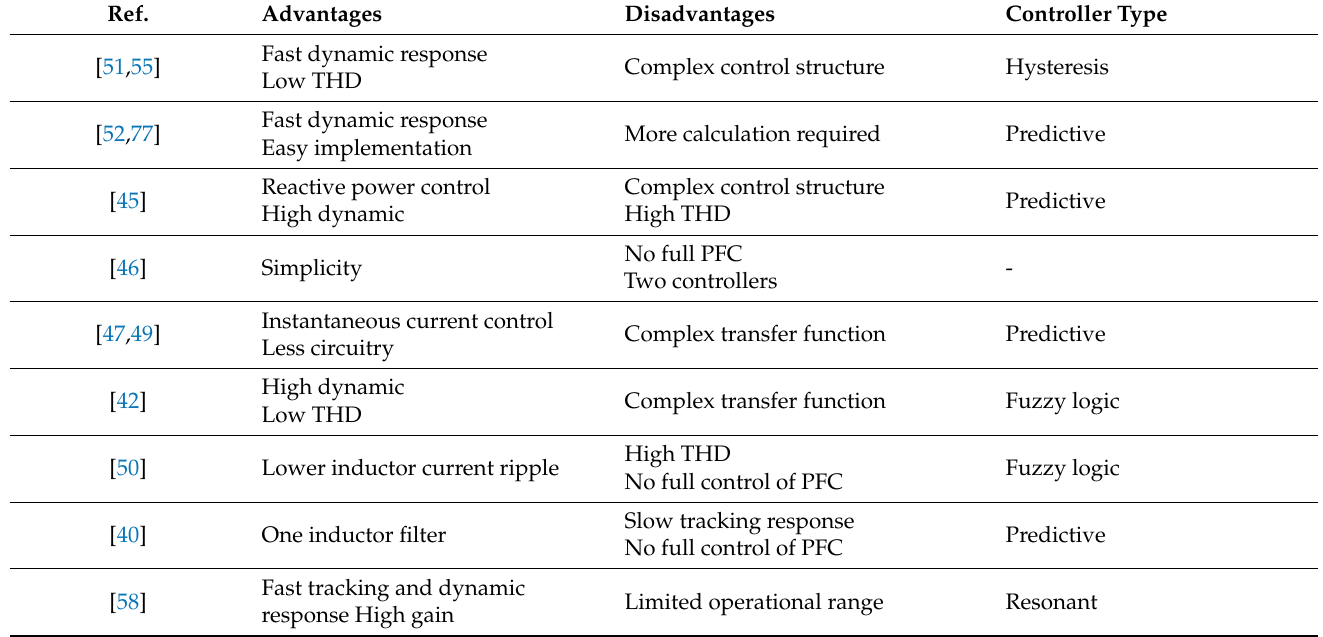
Table 4. Summary of control implementation of transformer and transformerless bidirectional topologies for DC distribution